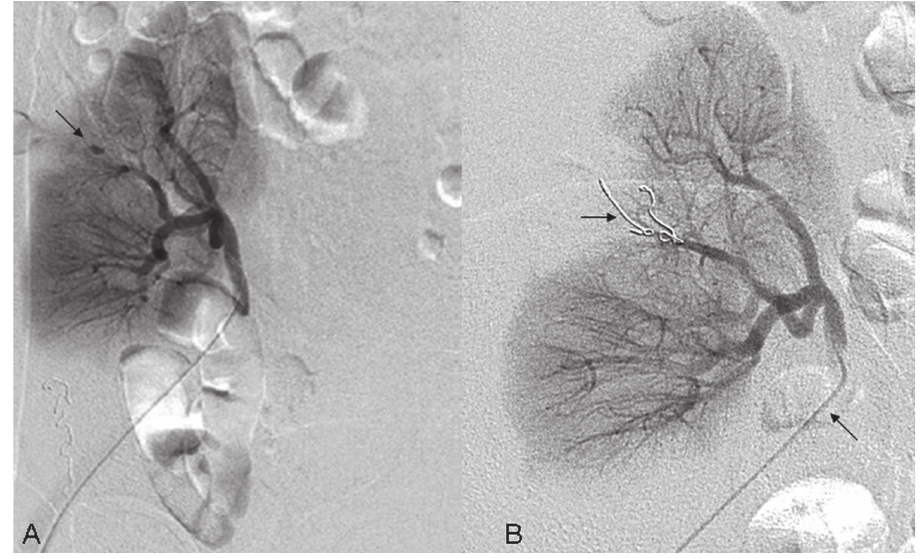
Figure 4 - Doppler control demonstrating the closure of